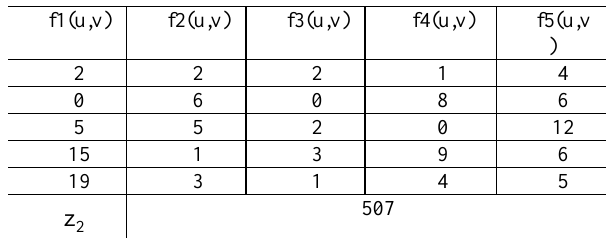
Table 2: Optimal flows of basic components